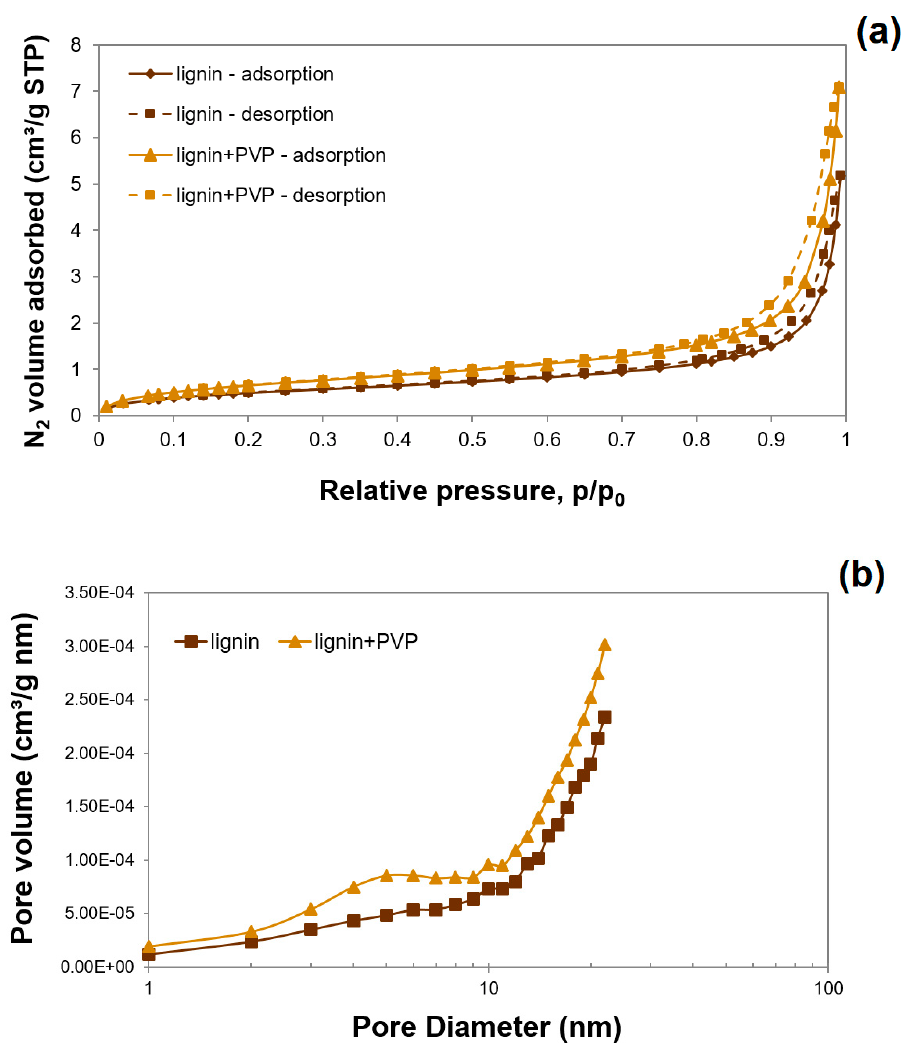
Figure 5. N 2 adsorption/desorption isotherms ( a ) and pore size distribution ( b ) of the lignin and lignin + PVP samples.